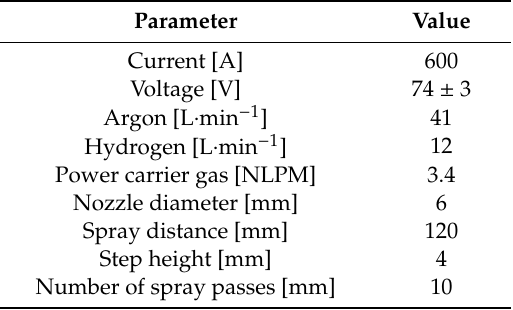
Table 1. Atmospheric plasma sprayed (APS) process parameters for alumina powders.